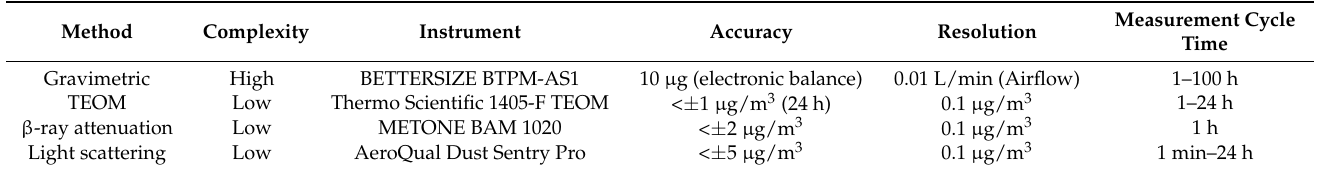
Table 1. Comparison of particulate matter monitoring